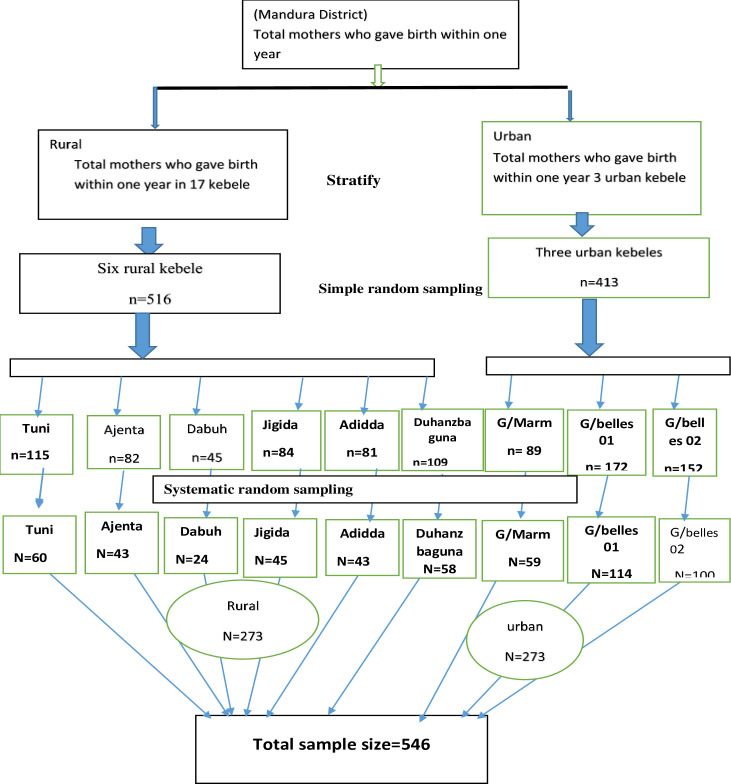
Schematic presentations of sampling procedures on delivery service utilizations and associated factors among mothers in Mandura district, 2019.